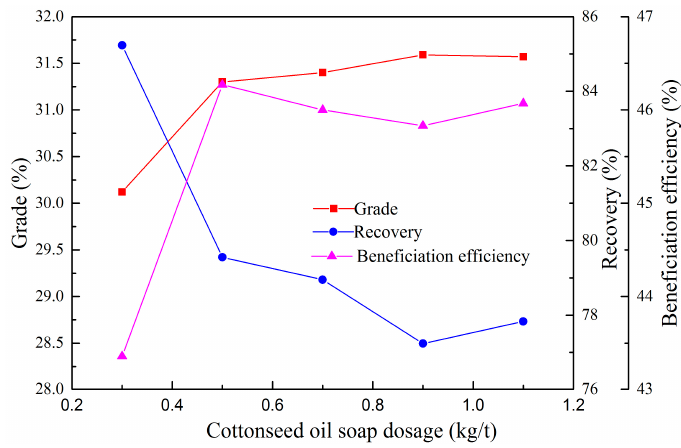
Figure 6. Effect of the cottonseed oil soap dosage on the reverse flotation of the rougher concentrate.